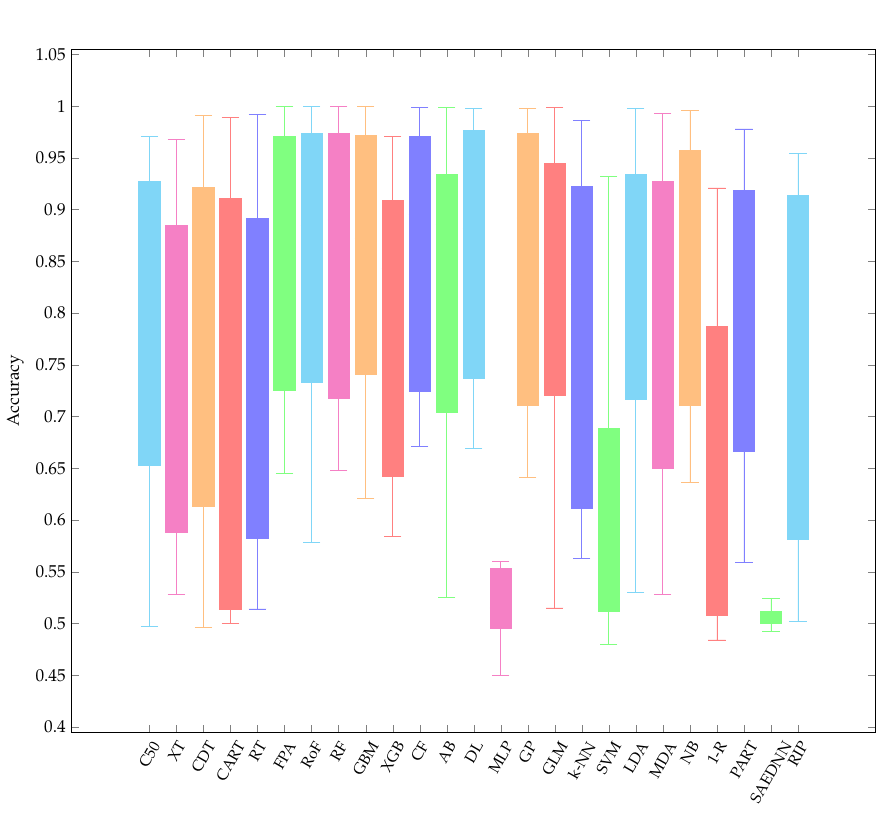
Figure 4. Performance AUC for each classifier w.r.t mean 10ho